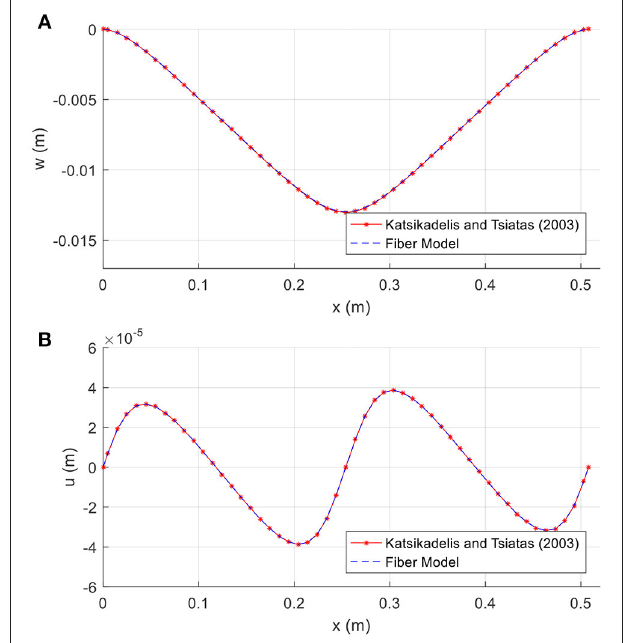
FIGURE 4 | Profiles of the (A) deflection and (B) axial displacement in Example 1.